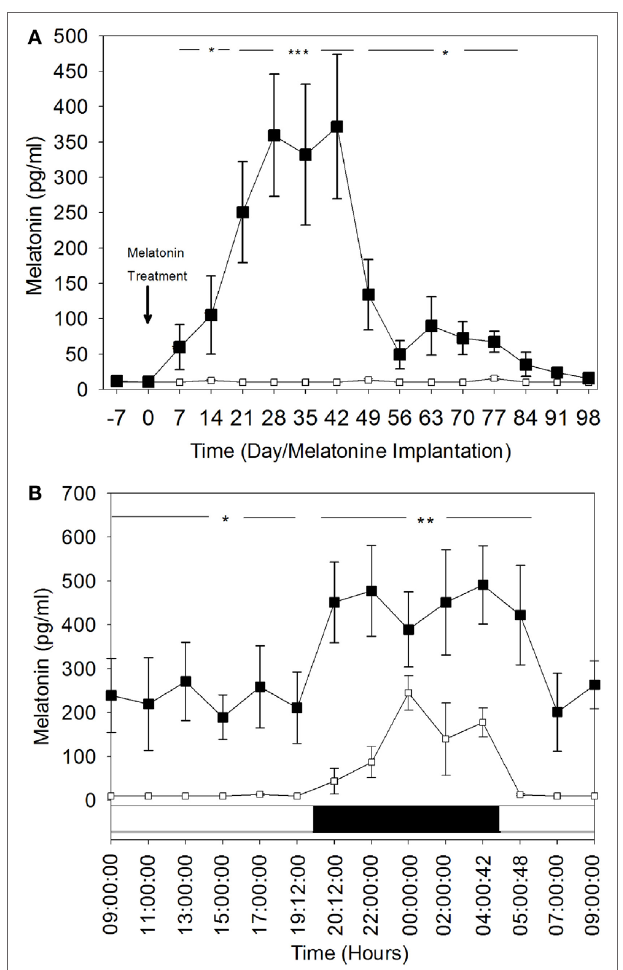
FigUre 1 | Rhythm of melatonin secretion in camels [Melatonin-treated ( ◾ ) and control groups ( ◽ )] during 24 h on May 16th: day 26 after the establishment of the artificial long photoperiod (16L: 8D) in the melatonin-treated group; the control group remained under outdoor natural photoperiod. The black bar corresponds to the duration of darkness of LD-cycle during the artificial long photoperiod of the melatonin-implanted group and the white bar is the duration of night in the outdoor natural conditions of the control group. Values are expressed as mean ± SEM. The significance levels for differences between treatments (ANOVA) are indicated: * P <